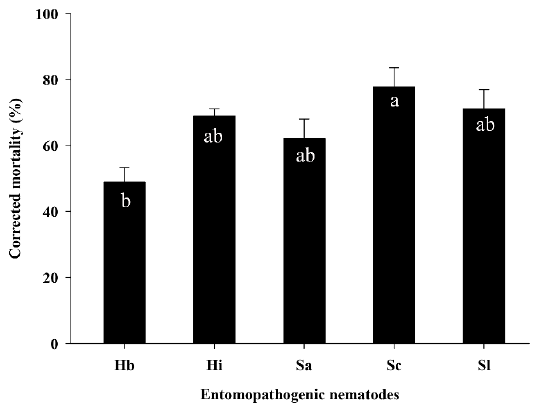
Figure 3. Corrected mortality of Spodoptera frugiperda in the corn pot assay. Sixth-instar larvae ( n = 5 per pot) of S. frugiperda were treated with entomopathogenic nematodes (EPNs) ( n = 25 infective juveniles / cm 2 ) in a corn pot and mortality was determined 5 days after treatment. EPNs: Heterorhabditis bacteriophora (Hb), Heterorhabditis indica (Hi), Steinernema arenarium (Sa), S. carpocapsae (Sc), and S. longicaudum (Sl). The same letters in a bar indicate that there was no significant difference in mortality between EPNs ( p > 0.05, Tukey’s test).